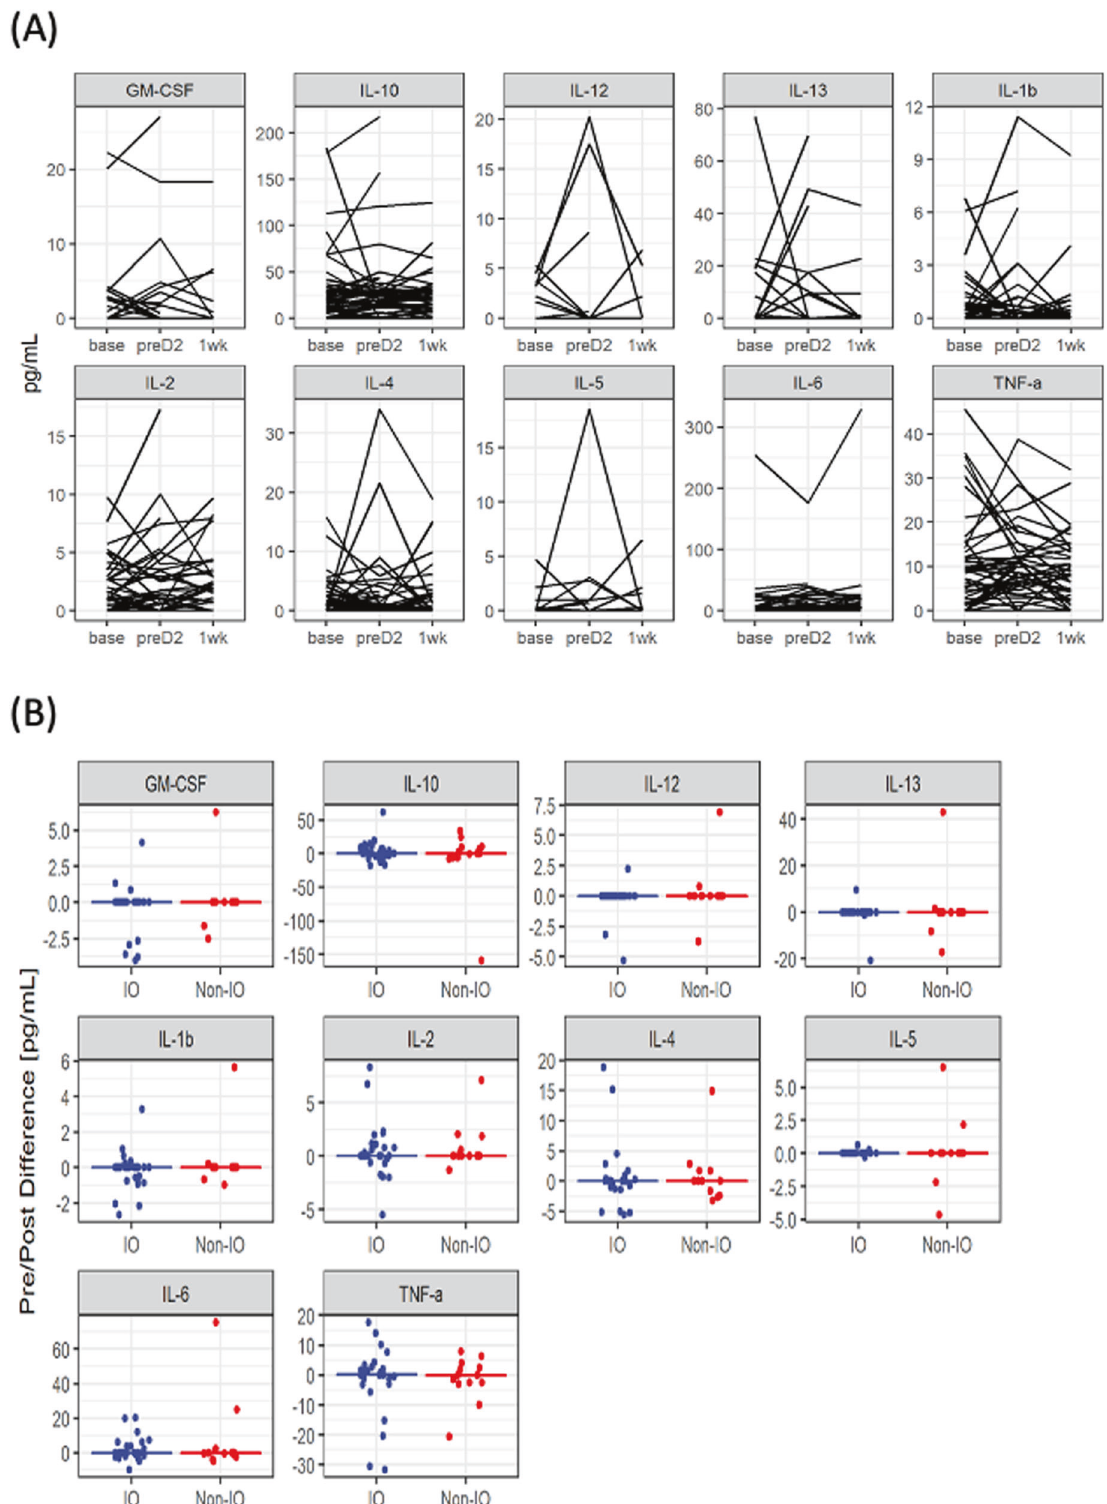
Fig. 3 Cytokine dynamics during initial vaccination series. A Longitudinal plots of cytokine concentration (pg/mL) at baseline (BASE, n = 51), prior to second vaccination dose (preD2, n = 48), and 1 week (1wk, n = 42) after the second dose for all patients; lines connect paired samples, there were no statistically signi fi cant differences found by Wilcoxon matched pairs signed rank test. IFN- γ not shown as levels were undetectable at all timepoints. B Plots of change from baseline to 1 week post 2nd vaccination dose, comparing IO ( n = 35)/non-IO ( n = 16) treatment groups. Each point represents the change in median cytokine level from baseline to 1 week post second vaccine dose. The line represents the median of each group. There were no statistically signi fi cant differences found.